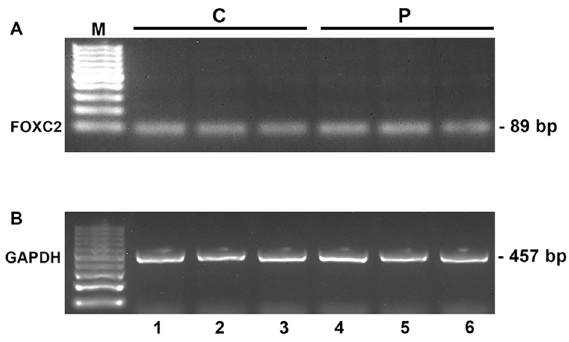
Figure 6. Expression analysis of FOXC2 in peripheral blood cells of LD patients. Gel images show gene expression of FOXC2 ( A ) and GAPDH ( B ), evaluated by comparative RT-PCR. mRNA levels of FOXC2 were similar in control subjects (lanes 1–3) and LD patients (lanes 4–6). M: 100-bp molecular weight marker. C: control subjects; P: patients. Lane 4: LD patient 1 carrying c.595dupC mutation.